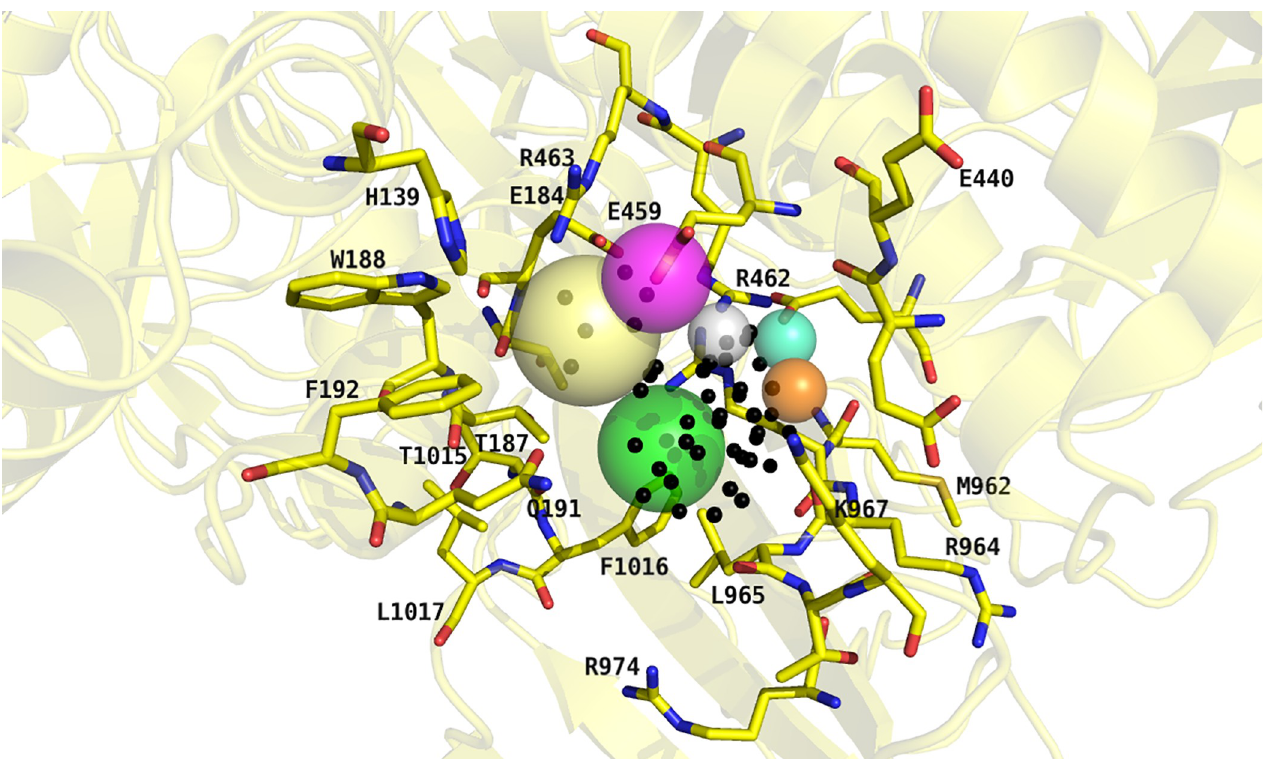
Fig 3. Pharmacophore hypothesis represented by colour-coded spheres. The volumes of the spheres define the positions and sizes of the corresponding electronic and steric features in matching ligand conformations. Binding site residues are displayed with carbon atoms in yellow colour. Dummy atoms used to define the binding site region are indicated by black spheres. The pale-yellow and magenta spheres, respectively, indicate the placement of a hydrogen-bond donor or cationic centre to interact with E459. The green sphere represents the area that had to be addressed with hydrophobic substituents. The desired position for either a hydrogen-bond donor or acceptor interacting with E459 and R462, respectively, is indicated by a grey sphere. The anionic centre with hydrogen bond acceptor properties is depicted by a pale-cyan sphere, whereas the orange sphere accounts for a hydrogen bond acceptor possibly interacting with